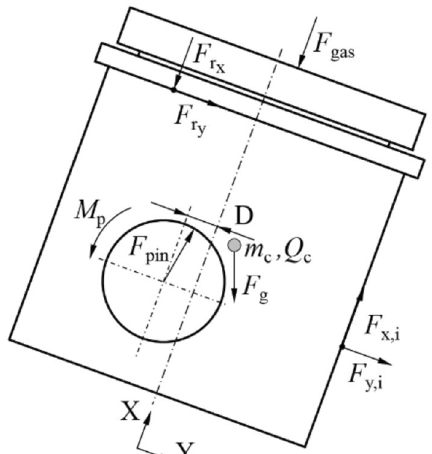
Figure 1. Piston kinematic analysis.